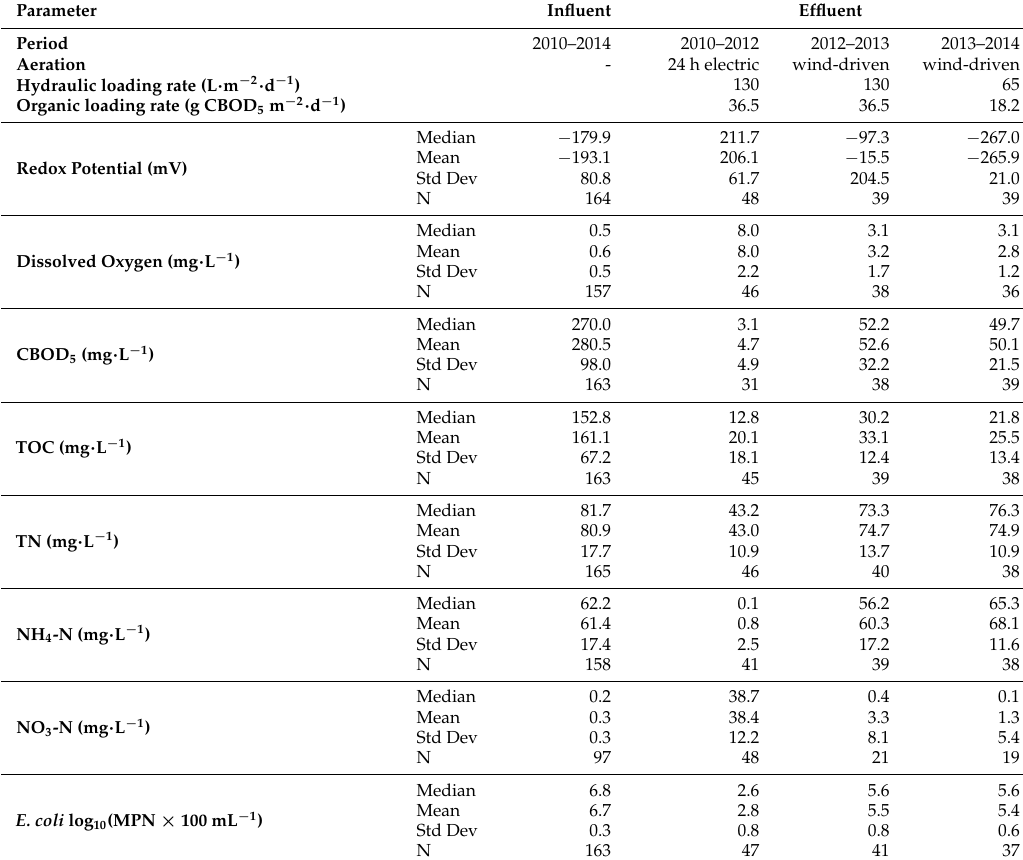
Table 1. Water quality results over the course of the